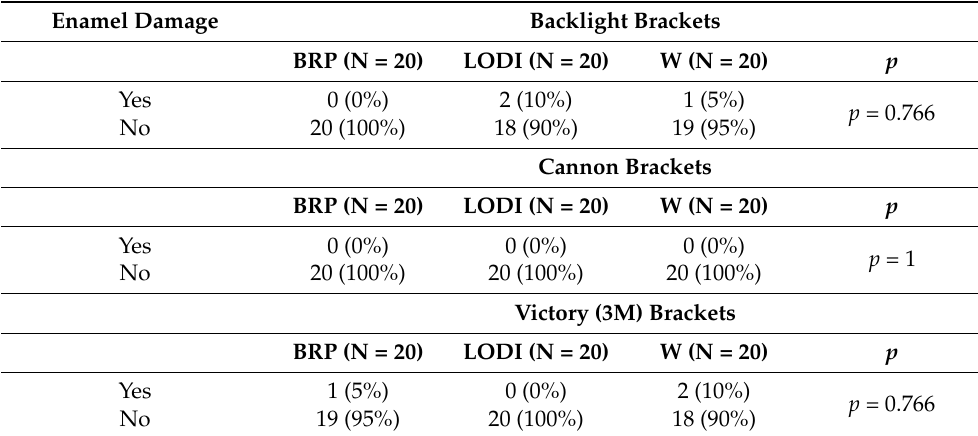
Table 1. Presence of enamel damage after bracket